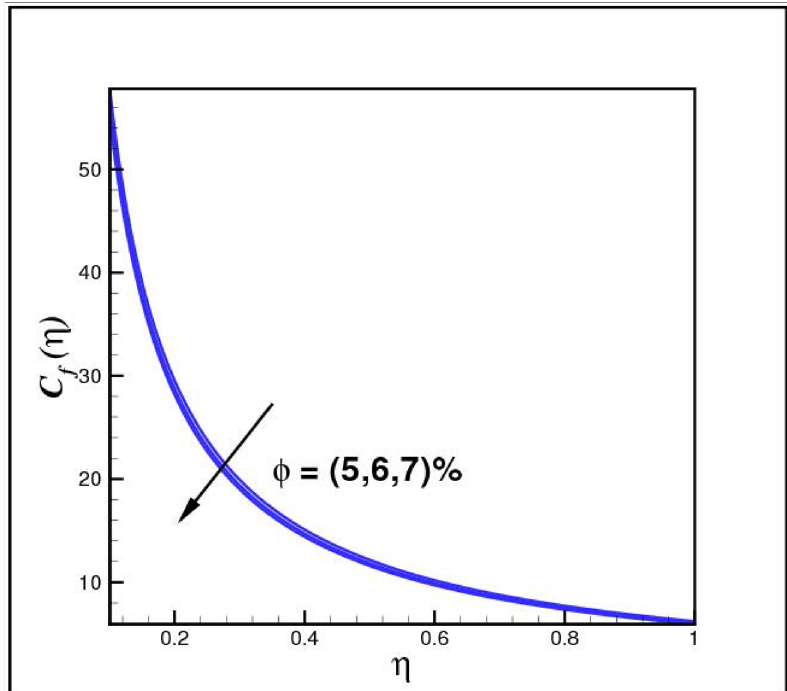
Figure 16. Impact of